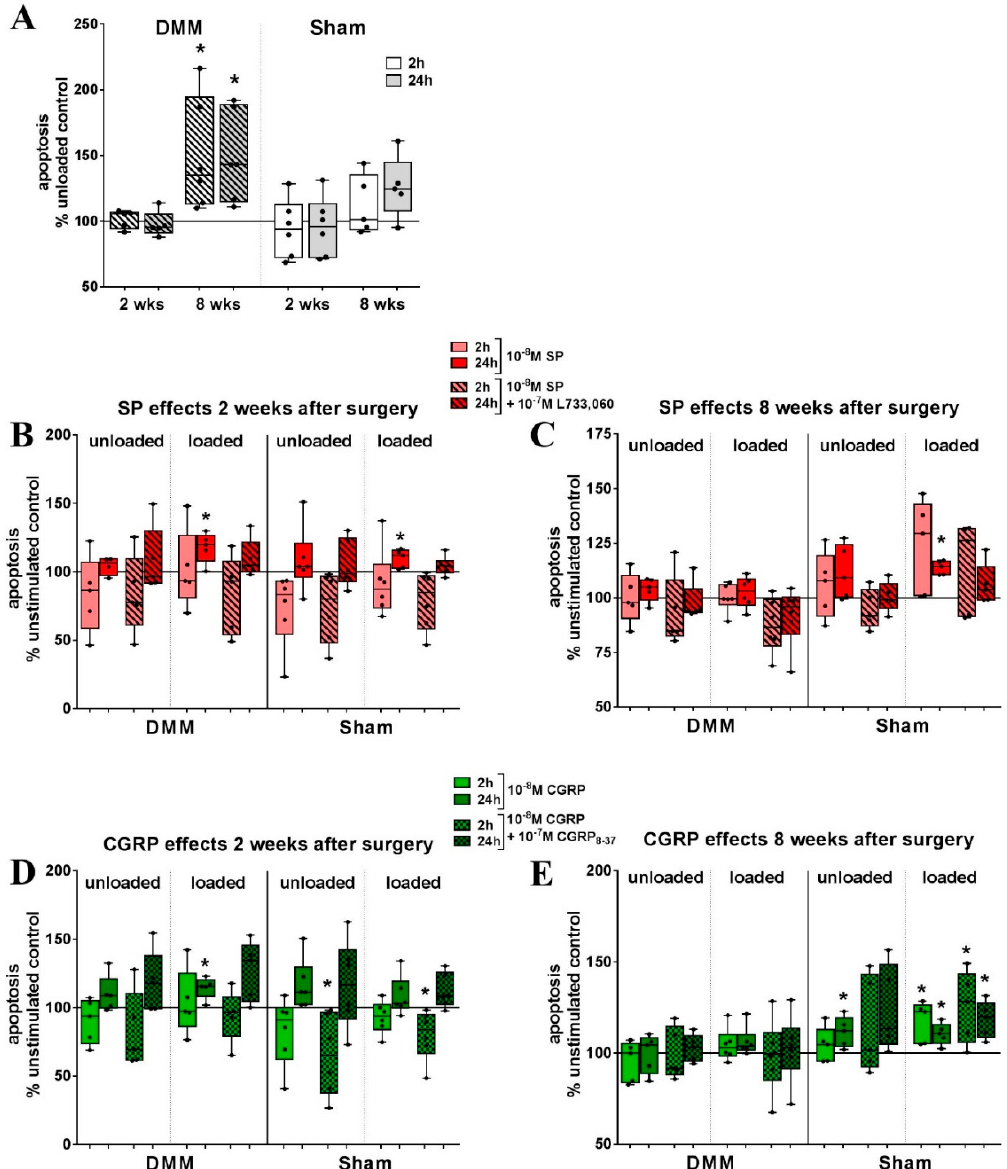
Figure 7. The impact of mechanical loading and sensory neuropeptide stimulation on the apoptosis